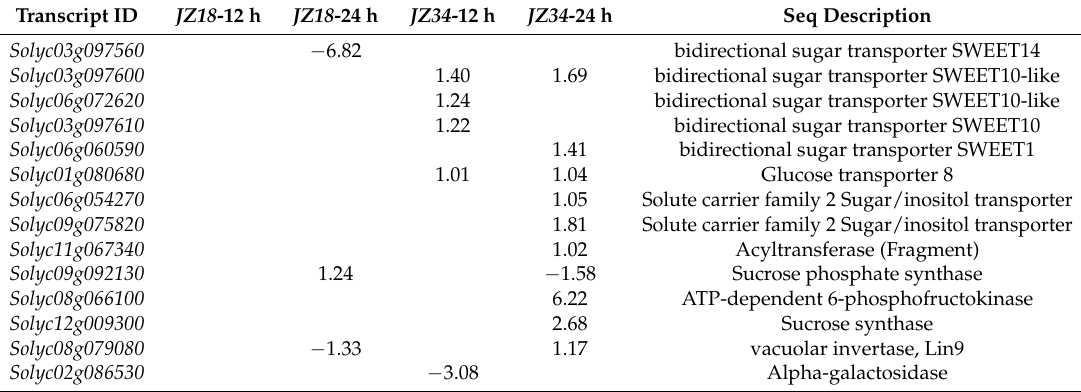
Table 7. Fold changes of DEGs related to glycometabolism in response to K + -deficiency (0.5 mM) stress. Transcript